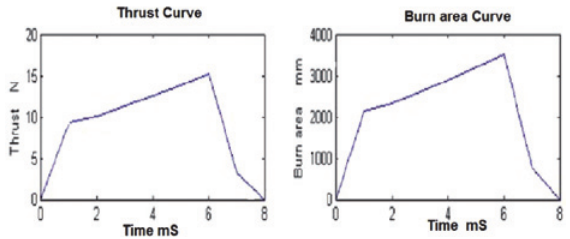
Fig. 14. (7-point) rose petal grain thrust and burn area time curves